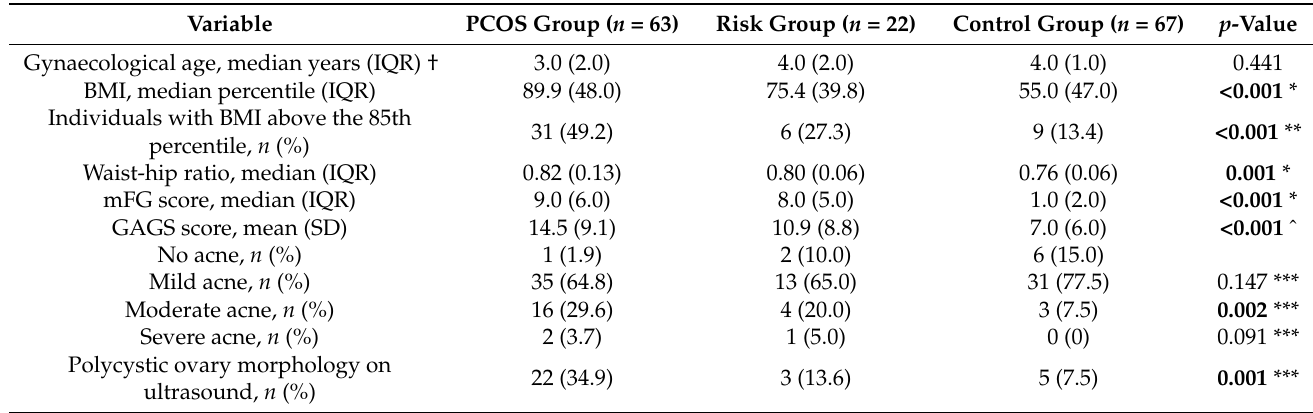
Table 1. Baseline clinical characteristics of the PCOS, risk and control